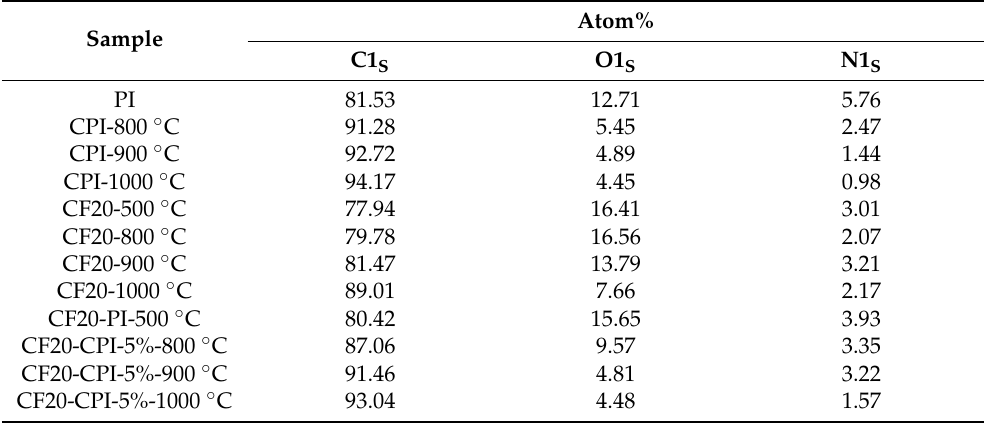
Table 2. Quantitative analysis of the surface C, O and N atomic percentages of polyimide aerogels, pre-carbonized foams and composite samples and their carbides under different carbonization